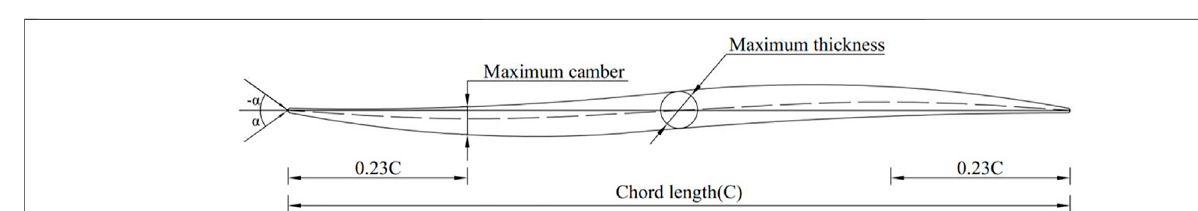
FIGURE 2 | Scheme of S-shaped hydrofoil operation.